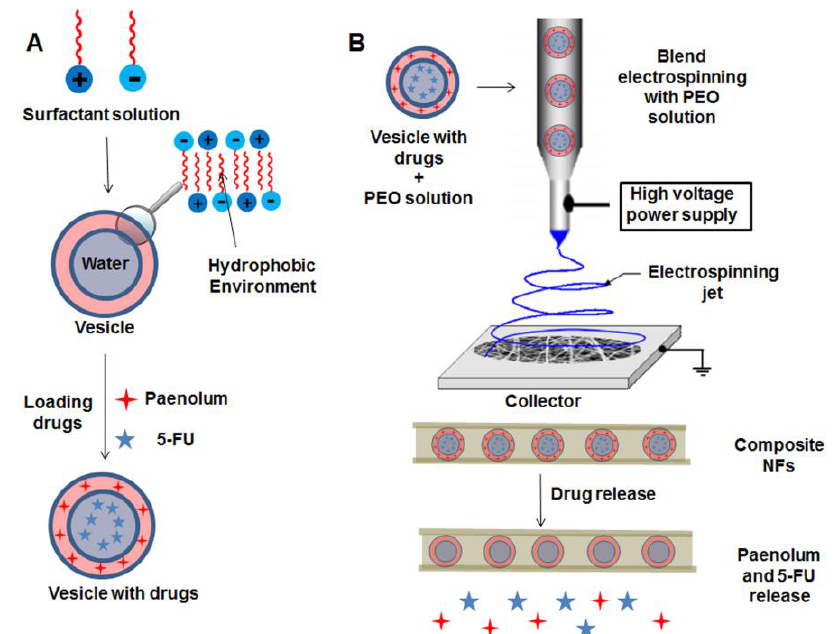
Figure 2. Schematic representation of the preparation of hydrophilic/hydrophobic electrospun composite fibers. ( A ) Accumulation of the drug mixture into the vesicle and ( B ) incorporation into the NF by electrospinning and drug release. Reprinted with permission from reference